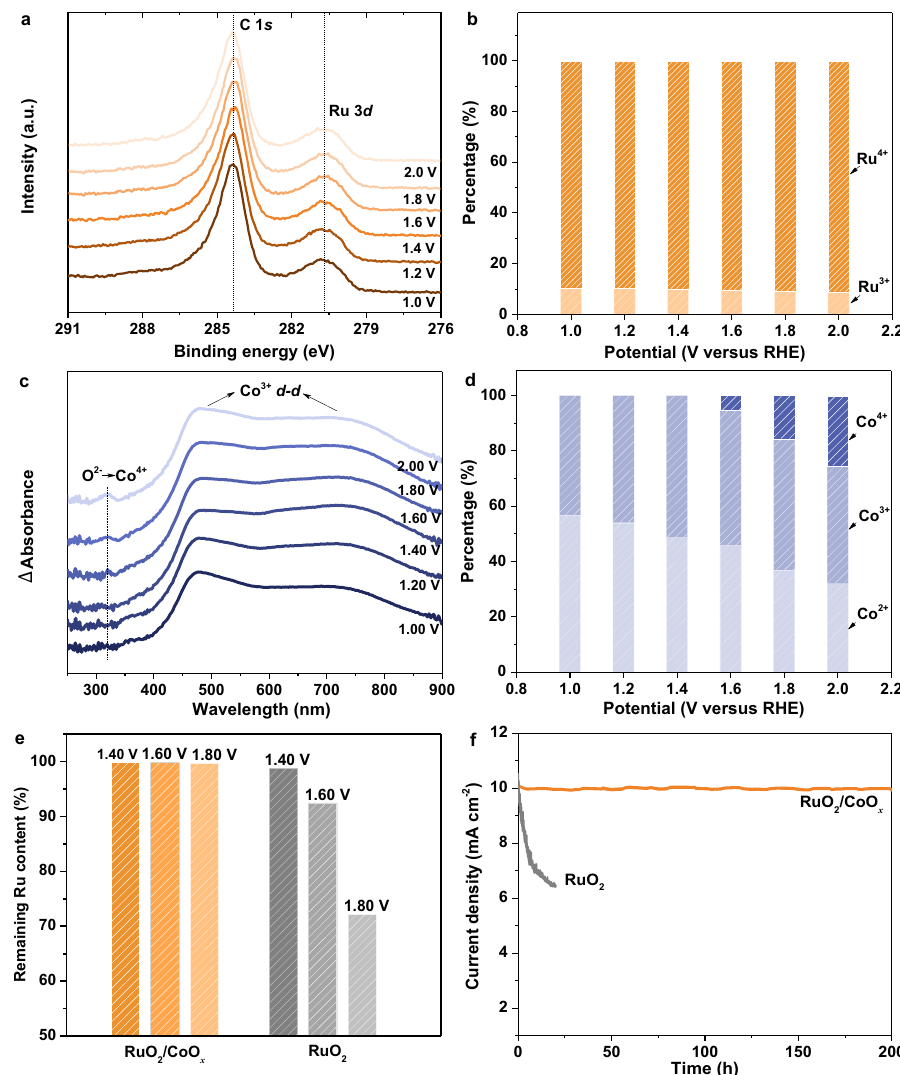
Fig. 3 | Investigation on in situ stability of RuO2/CoO x hybrid catalyst during OER.a , b In situ Ru 3 d XPSspectrarecorded atappliedpotentialduring 1.00 – 2.00 V RHE and corresponding Ru 3+ and Ru 4+ content ratios, respectively. c In situ UV – Vis spectrarecordedatappliedpotentialduring1.00 – 2.00V RHE .Thespectrumateach potentialwascollectedbysubtractingthespectrumofpristine RuO 2 /CoO x . d Co 2+ ,